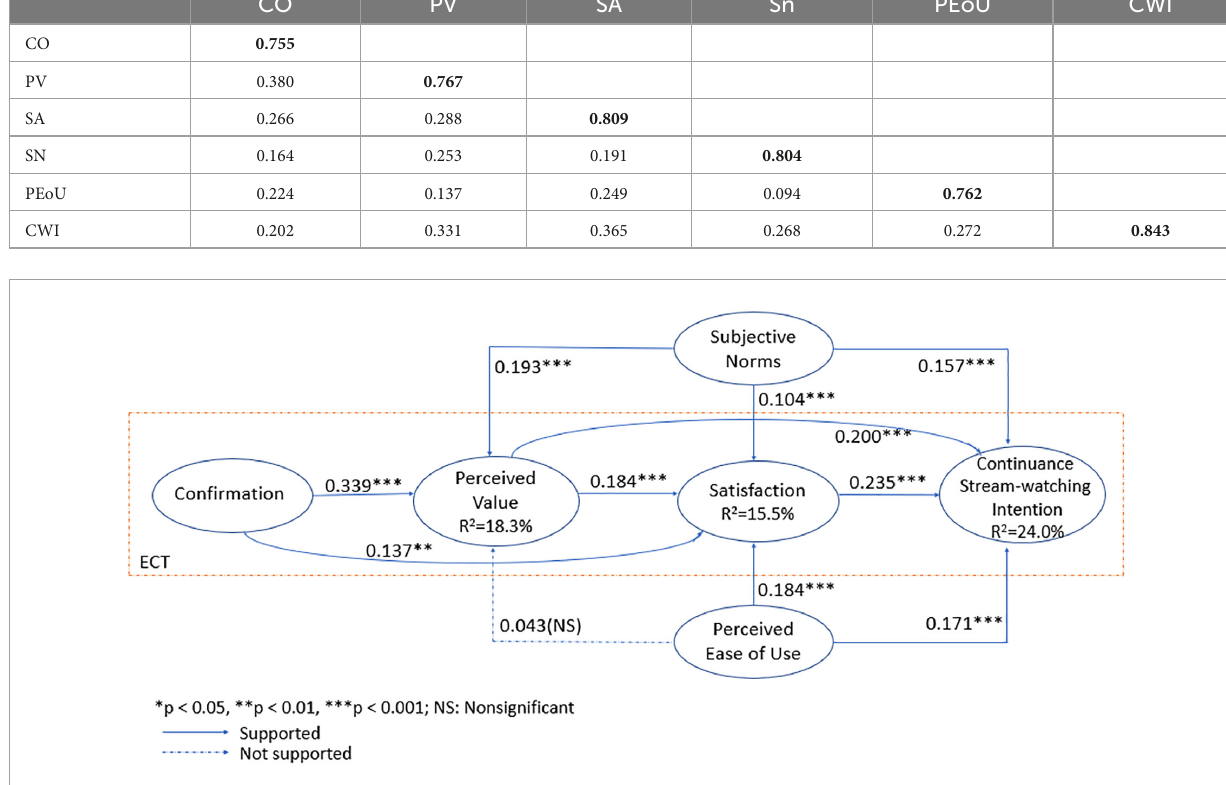
FIGURE3 Structural equation model results for